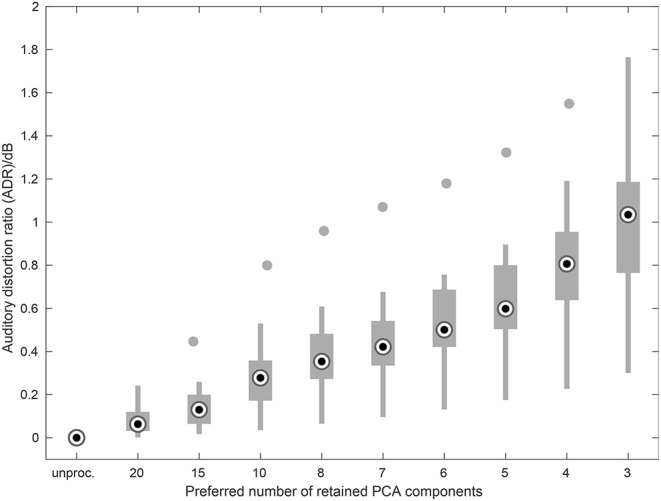
Auditory Distortion Ratio (ADR) plotted vs. the number of retained PCA components averaged over all pieces used in the listening experiments. Higher values indicate a decrease in spectral spread. Filled circles denote outliers.